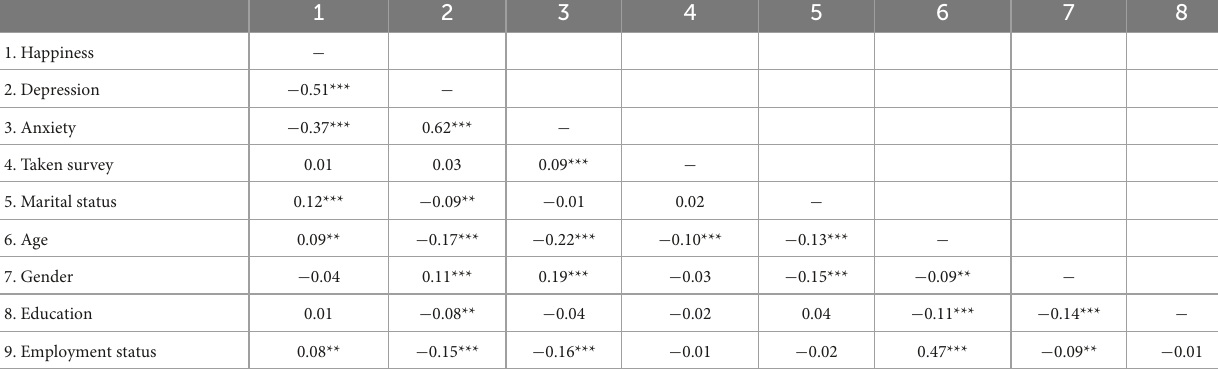
TABLE 2 Bivariate correlations for Study 1 with the full